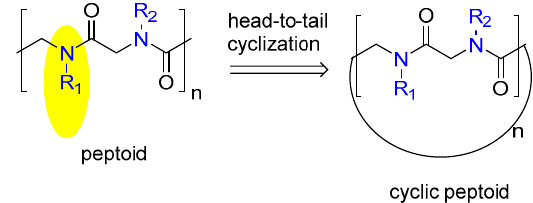
Figure 10. From a linear peptoid oligomer to a cyclic peptoid.